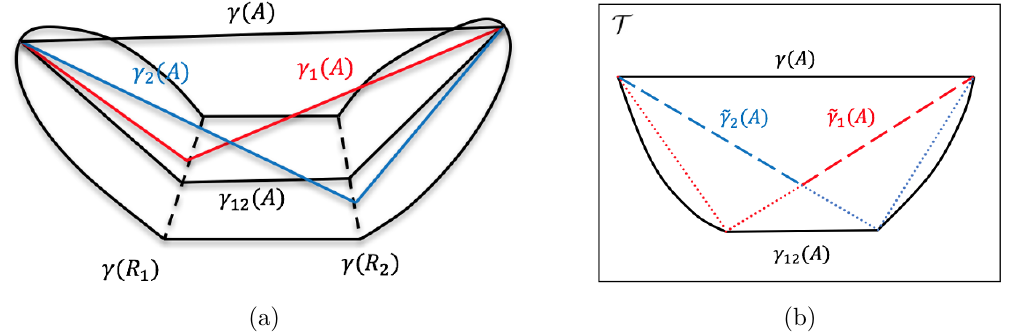
Figure 19. This is the case for constructive interference. In the right (cid:12)gure we see how we can apply the strong subadditivity (SSA) proof to this situation by projecting the surfaces (cid:13) 1 ; (cid:13) 2 to the same slice where (cid:13); (cid:13) 12 are. We recombine the projected surfaces ~ (cid:13) 1 and ~ (cid:13) 2 into the dashed part and the dotted part, then the length of the dashed part is less than (cid:13) , while the length of the dotted part is less than (cid:13) 12